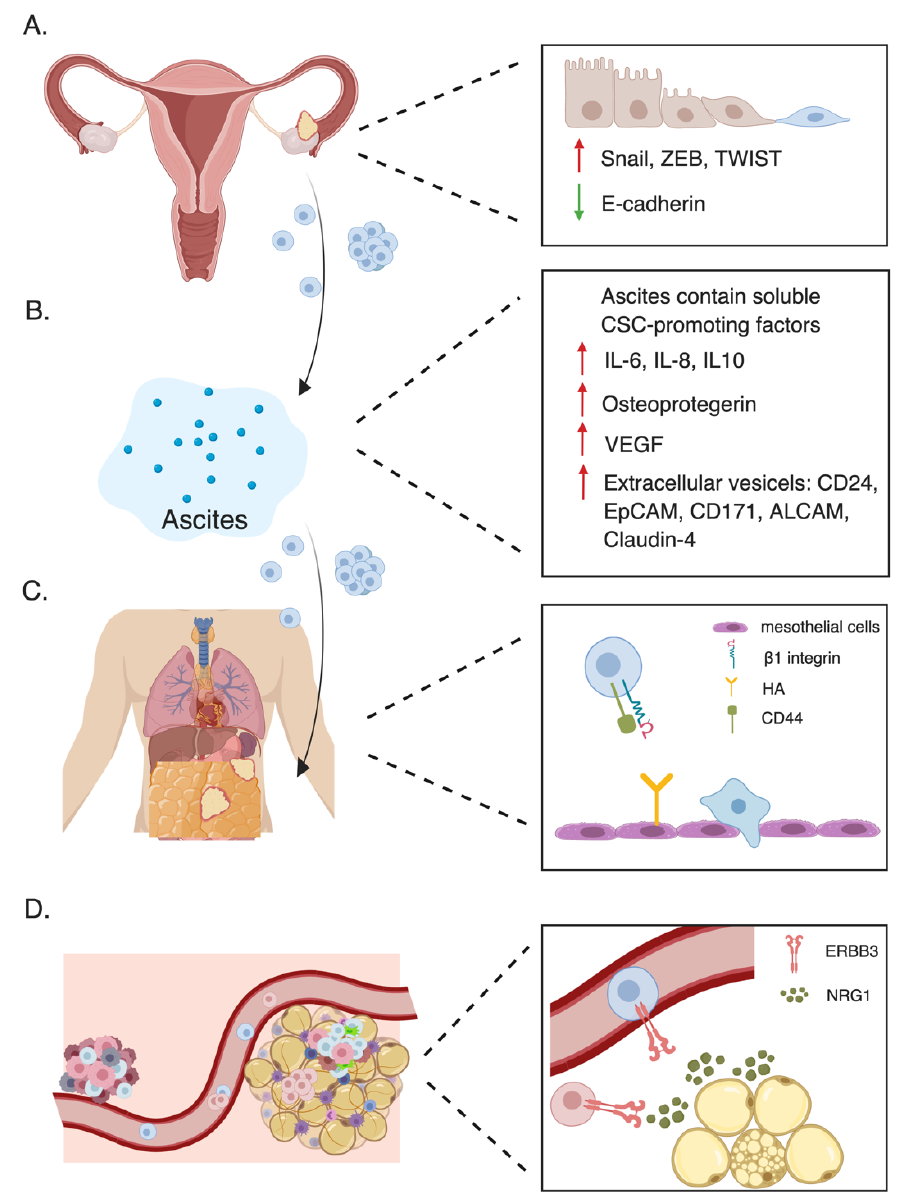
Figure 1. The involvement of OCSCs in passive tumor dissemination ( A – C ) and in hematogenous metastasis ( D ). ( A ) The cancer cells at primary site may undergo EMT, gain stem cell properties, and disperse into ascites as either single cell or multicellular spheroids. ( B ) Ascites provides floating cells with a CSC-promoting microenvironment. ( C ) Adhesion to mesothelium is facilitated by CD44 and β1 integrin heterodimer on the surface of floating cells. ( D ) Activated ErbB3/NRG1 axis promotes hematogenous metastasis to omentum.